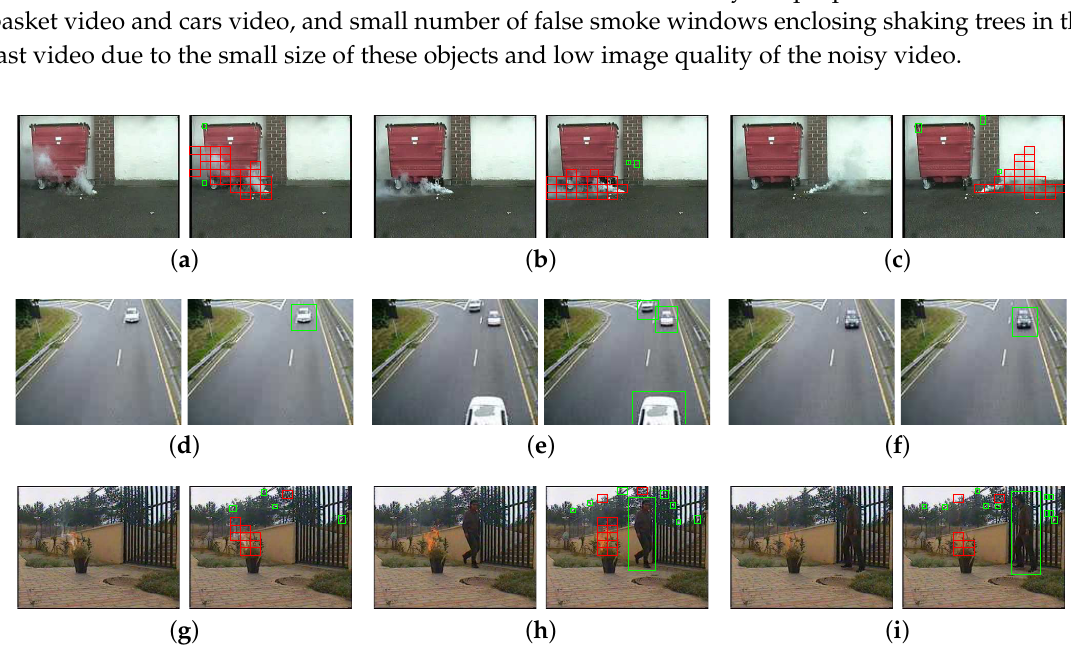
Figure 13. Detection results in three videos with or without smoke-fire. Smoke video with waste basket at frame ( a ) 121 ( b ) 166 and ( c ) 326. non-smoke video with cars on high way at frame ( d ) 11 ( e ) 26 and ( f ) 106. smoke-fire video with pedestrian at frame ( g ) 61 ( h ) 228 and ( i ) 244. Left image of each sub figure is the original frame image while the right one is the detected